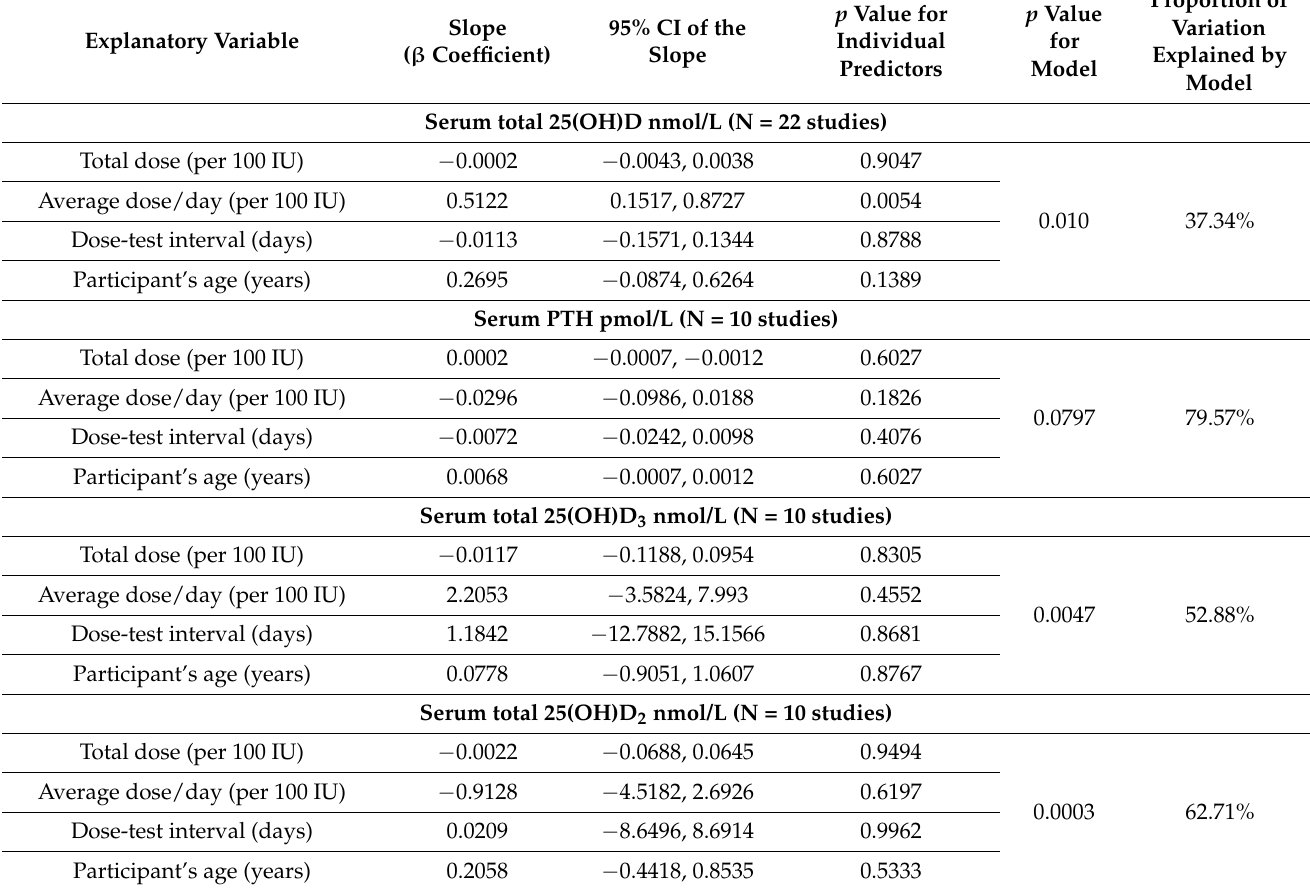
Legend/description for Table 3: Table presents the results of random-effect model (multivariate) meta-regression analyses investigating the relationship of “Mean age of the participants” (grand mean of both groups), “total dose (per 100 IU)” (sum of all doses received between baseline to final assessment), “average dose/day (per 100 IU)”(computed as the ratio of total dose and total study duration) and “Dose-Test Interval” (duration in days between the last intervention received and sample collection) with the outcome parameters (viz. the mean differences in 25(OH)D, PTH, 25(OH)D 3 and 25(OH)D 2 ) between the cholecalciferol and ergocalciferol groups.